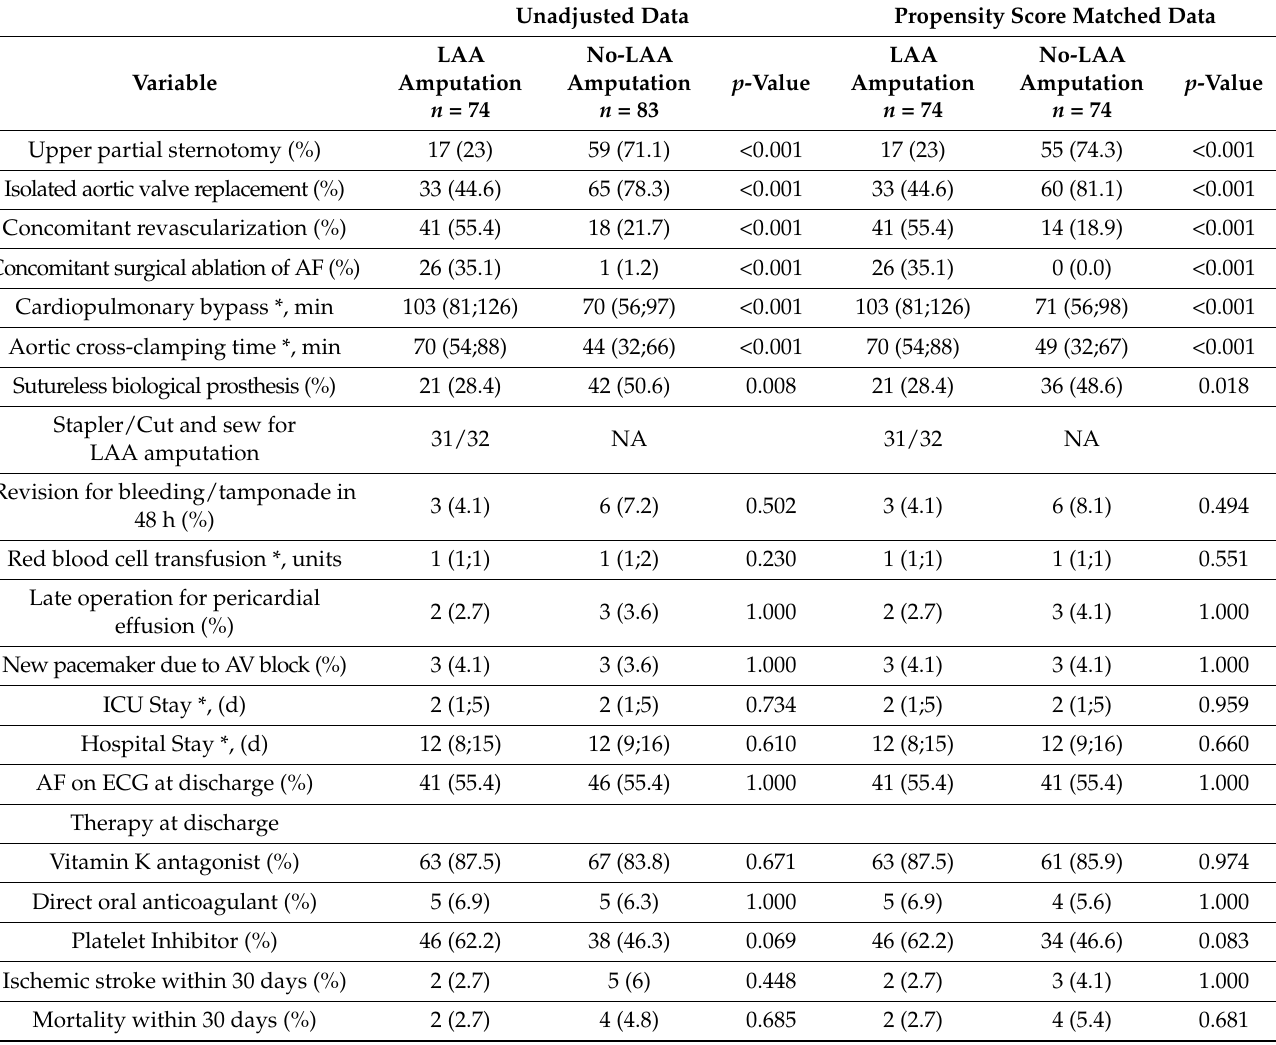
Table 2. Operative characteristics of patients with LAA vs. No-LAA amputation, unmatched and matched according to baseline